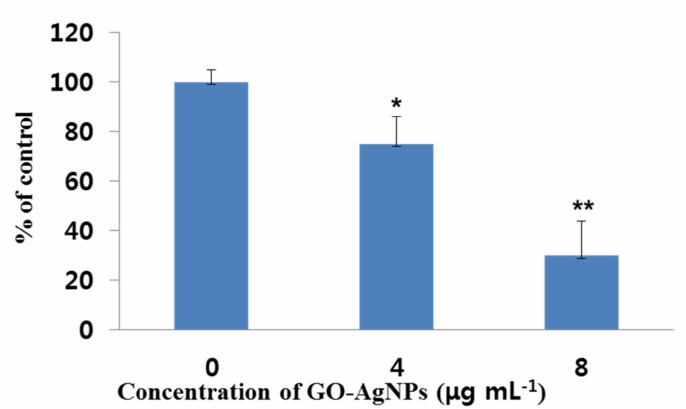
Figure 6. Measurement of superoxide dismutase (SOD) production in GO-AgNP-treated cells. Caprine fetal fibroblast cells (CFFCs) were treated with 0, 4, and 8 µ g/mL of GO-AgNPs for 24 h. The percentage of SOD relative to the control group (0 µ g/mL) was determined. Values are presented as the mean ± SD of four independent experiments (* p < 0.05; ** p < 0.01).